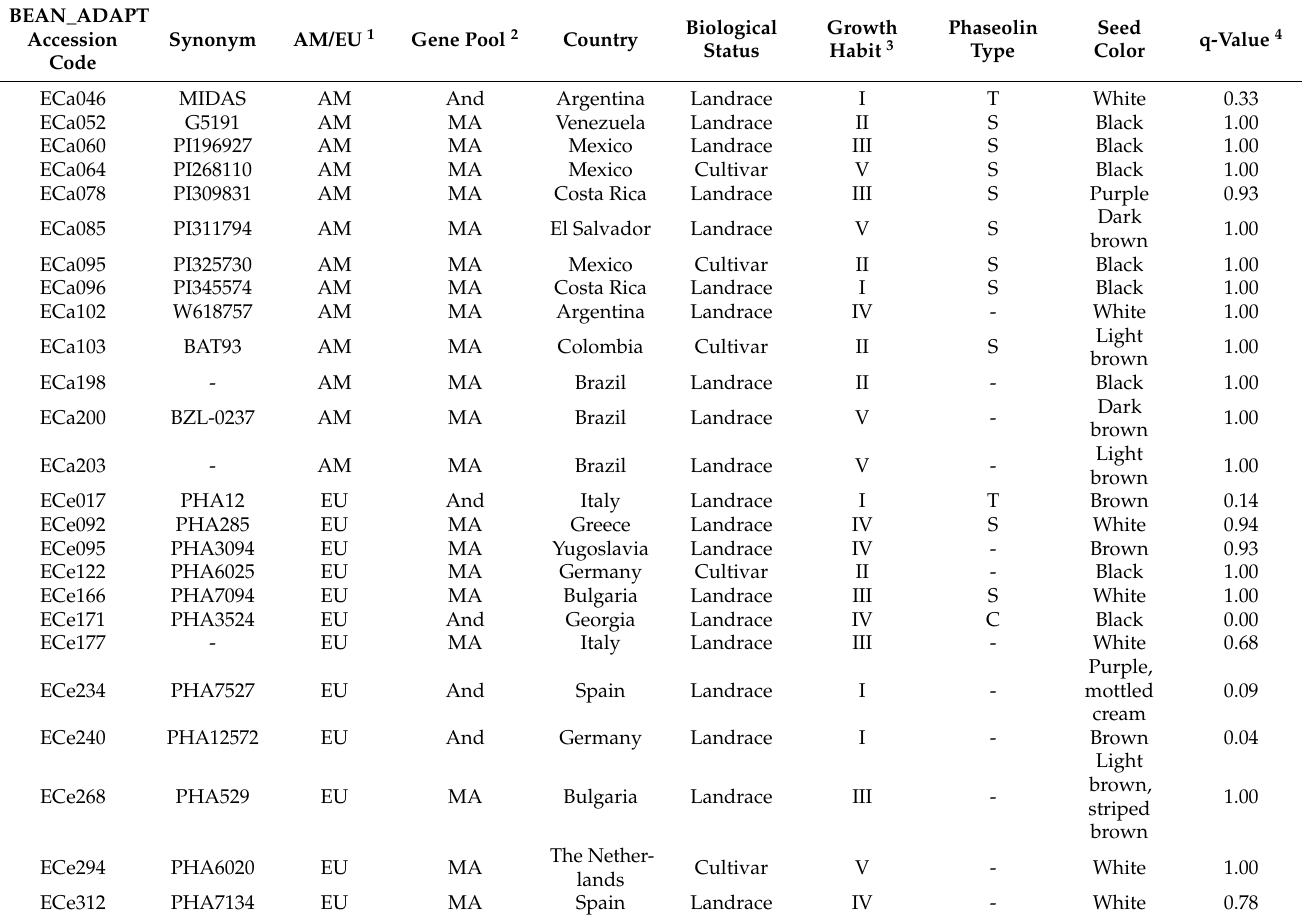
Table 1. Common bean accessions used in the present